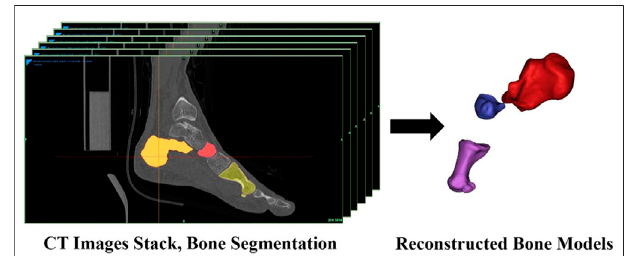
FIGURE 1 | Reconstruction of the fi rst metatarsal, navicular, and